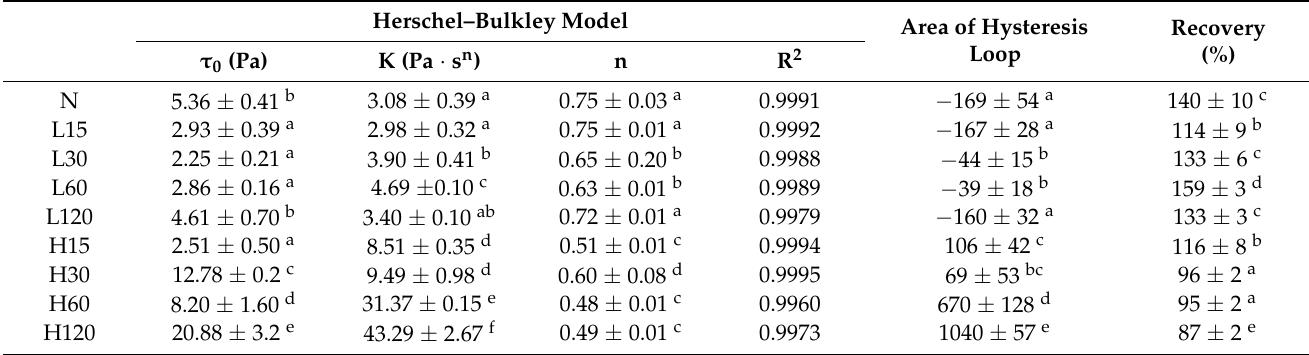
Table 6. Parameter of the Herschel–Bulkley model describing flow curves of native starch and distarch phosphate pastes and recovery.